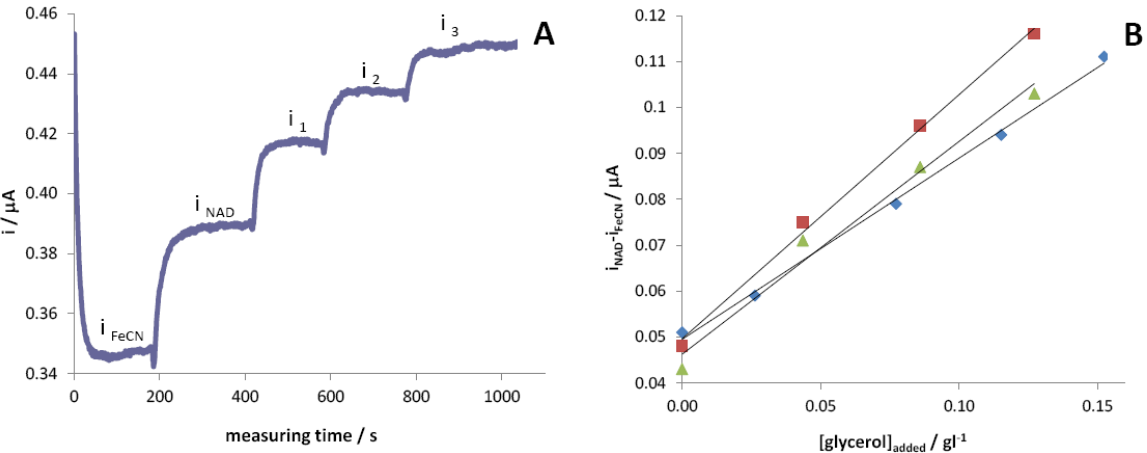
Figure 1. ( A ) Amperometric signal obtained at +0.35 V by subsequent additions of glycerol standard solution in a grape juice diluted eight times with the buffer solution containing [Fe(CN) ] 3− ; ( B ) three consecutive calibration plots obtained from the analysis 6 of the same